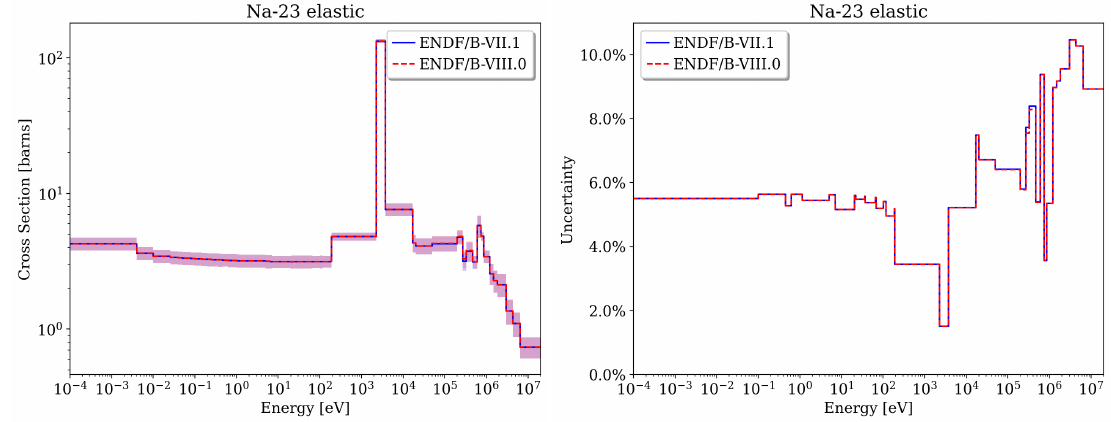
Figure A1. 23 Na elastic scattering nominal data and uncertainty.